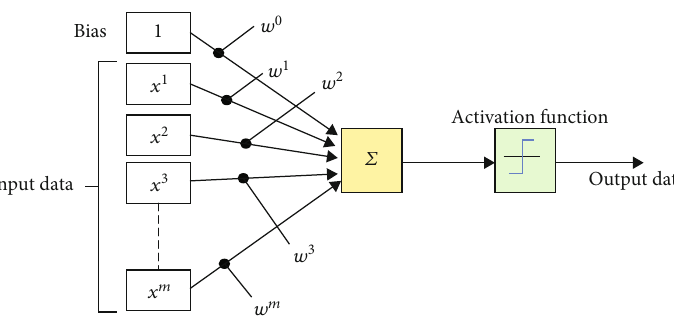
Figure 2: Functionality of the ANN model for the energy production forecast of a photovoltaic